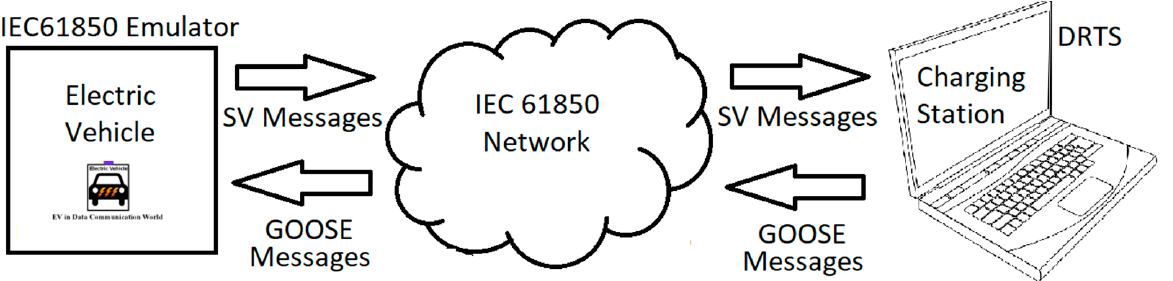
Figure 3. The HIL test set ‐ up for model validation.